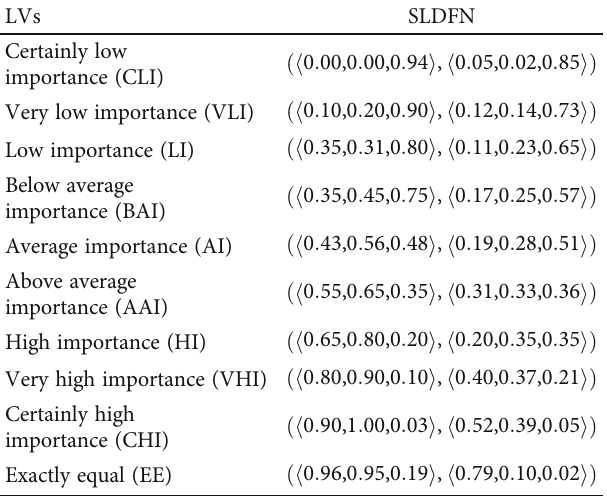
Table 2: LTs for signi fi cant criteria